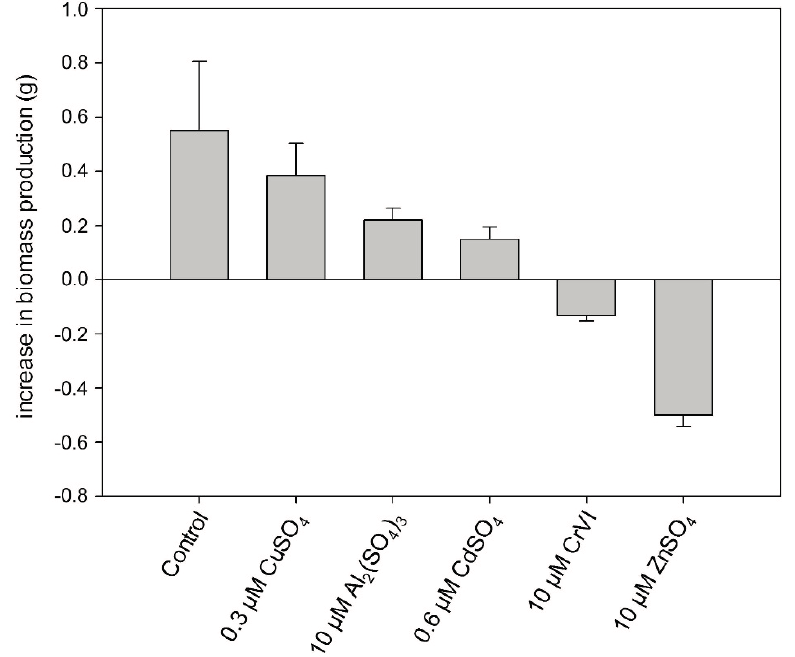
Figure 4. Increase in biomass production during exposure of Desmidium filaments to different metals in liquid culture medium for 21 days. Data are the means of three independent experiments ± standard error